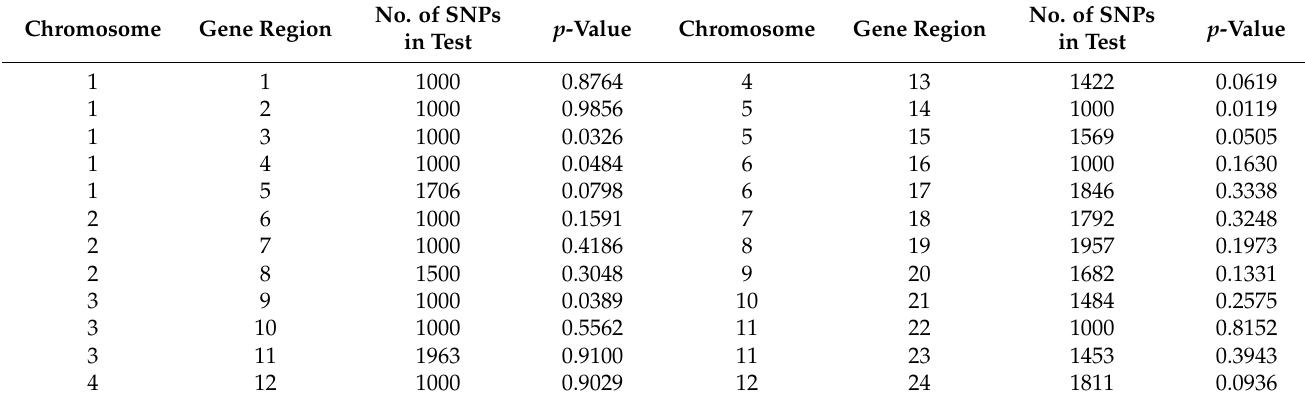
Table 6. The number of SNPs and the p -value of the association analysis of each gene region of Culm habit based on